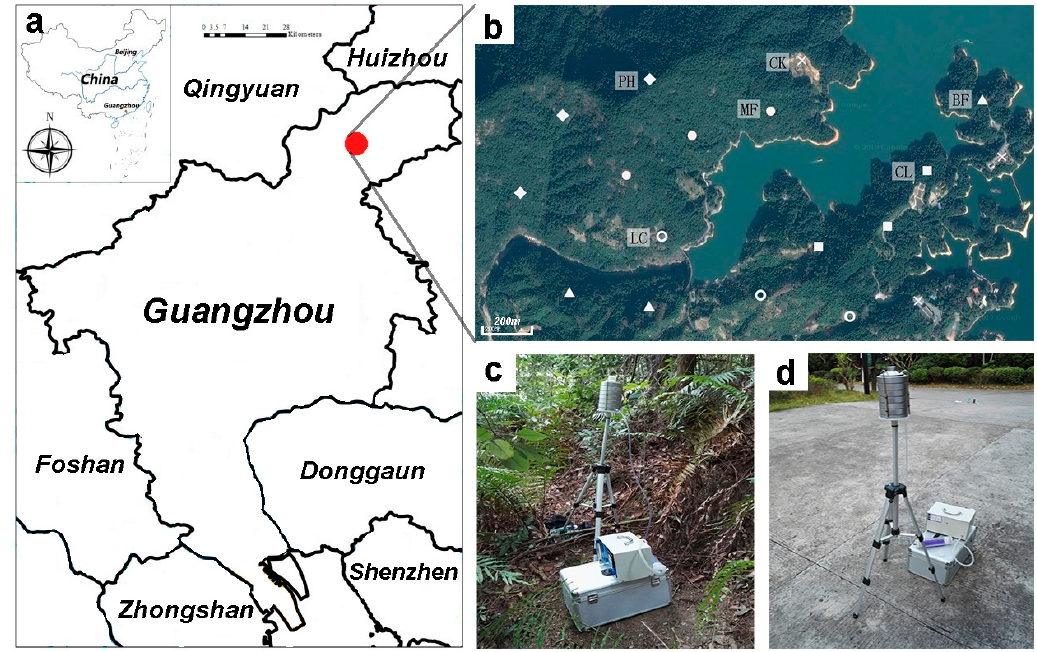
Figure 1. ( a ): Location map of the Liuxihe Forest Park, South China; ( b ): Distribution of sample sites (CL = Cunninghamia lanceolata forest; MF = coniferous and broad-leaved mixed forest; BF = broad-leaved mixed forest; LC = litchi forest; PH = Phyllostachys pubescens forest; CK = control check group); ( c ) and ( d ):